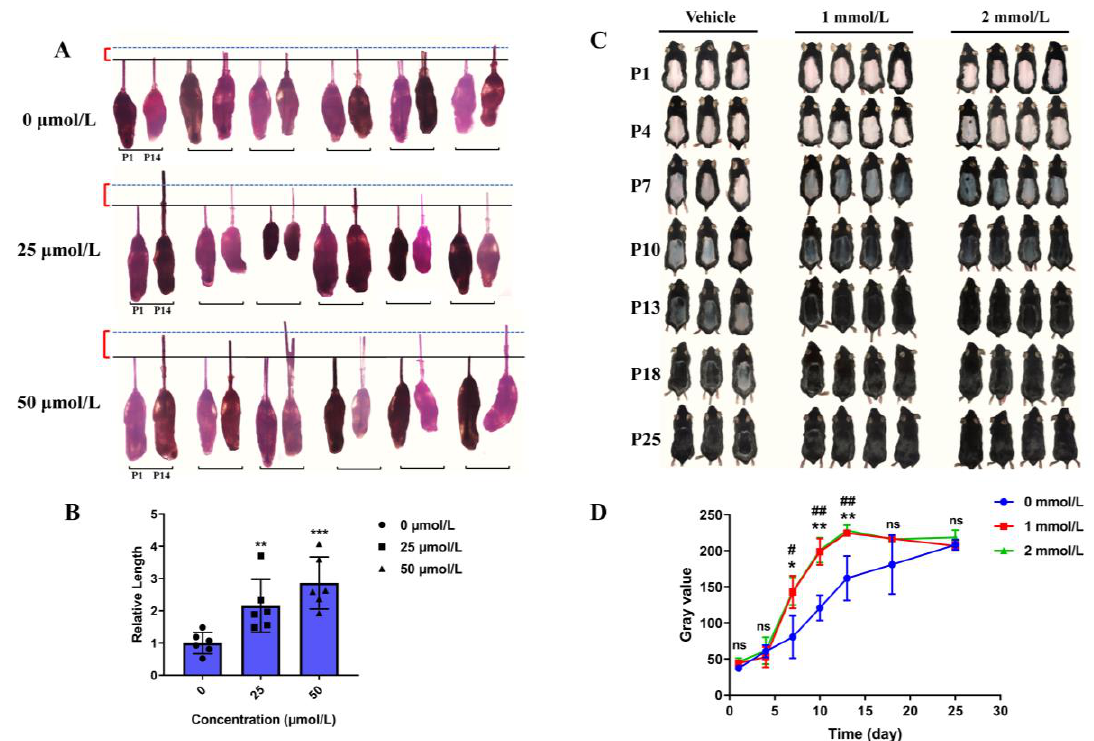
Figure 2. Hordenine promoted the elongation of hair shaft and accelerated hair regeneration of mice. ( A ) Mouse vibrissa follicles were isolated and cultured in William’s E with or without Hordenine for 14 days. Images of mouse vibrissa follicles were taken at day 1 and 14, respectively ( n = 6). ( B ) The elongation length of mouse vibrissa follicles after Hordenine’s treatments for 14 days ( n = 6). ( C ) Shaved dorsal skin of C57BL/6 mice was topically treated with vehicle or Hordenine (1 mmol/L or 2 mmol/L) for 25 days. Typical photos were taken to show hair regrowth of mouse dorsal hair. ( D ) The rate of hair regrowth was quantified by using the software of Image J. Data are expressed as means ± SD. * p < 0.05, ** p < 0.01, *** p < 0.001, 1 mmol Hordenine versus control; # p < 0.05, ## p < 0.01, 2 mmol Hordenine versus control.